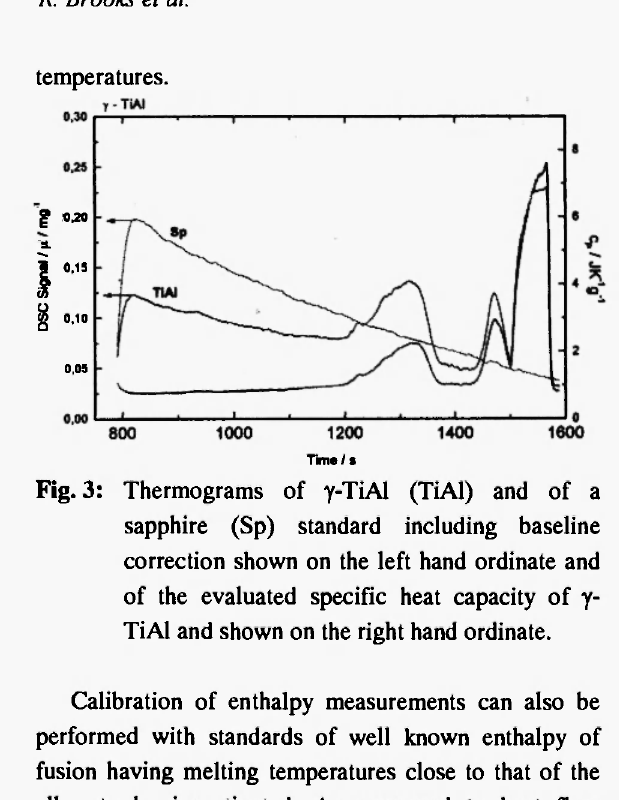
Fig. 3: Thermograms of γ-TiAl (TiAl) and of a sapphire (Sp) standard including baseline correction shown on the left hand ordinate and of the evaluated specific heat capacity of γ- TiAl and shown on the right hand ordinate.